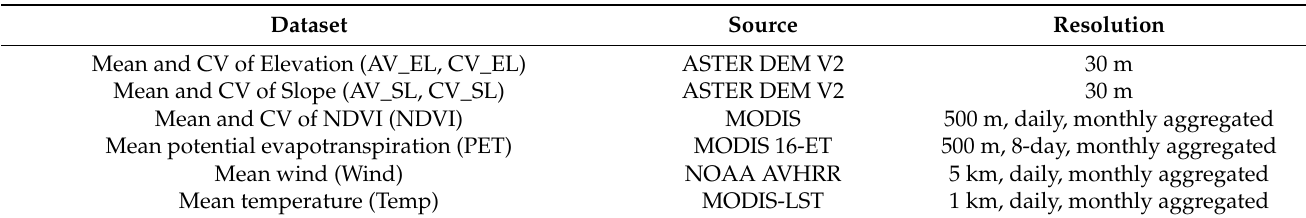
Table 4. Types and Source of Ecological